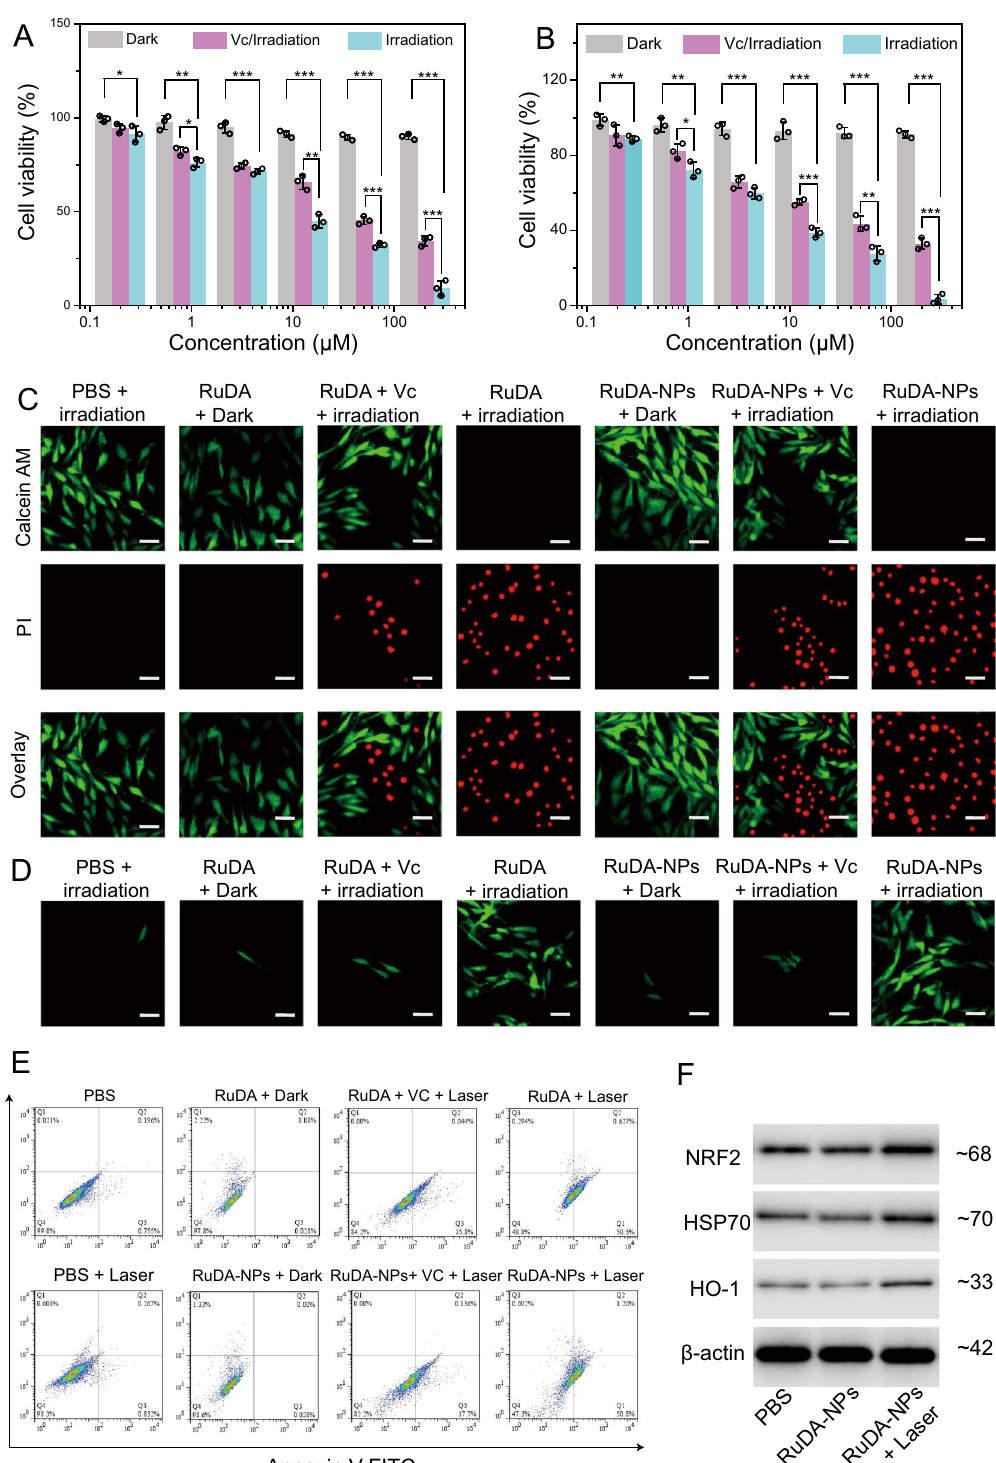
presence of Vc, similar to the result of confocal fl uorescence